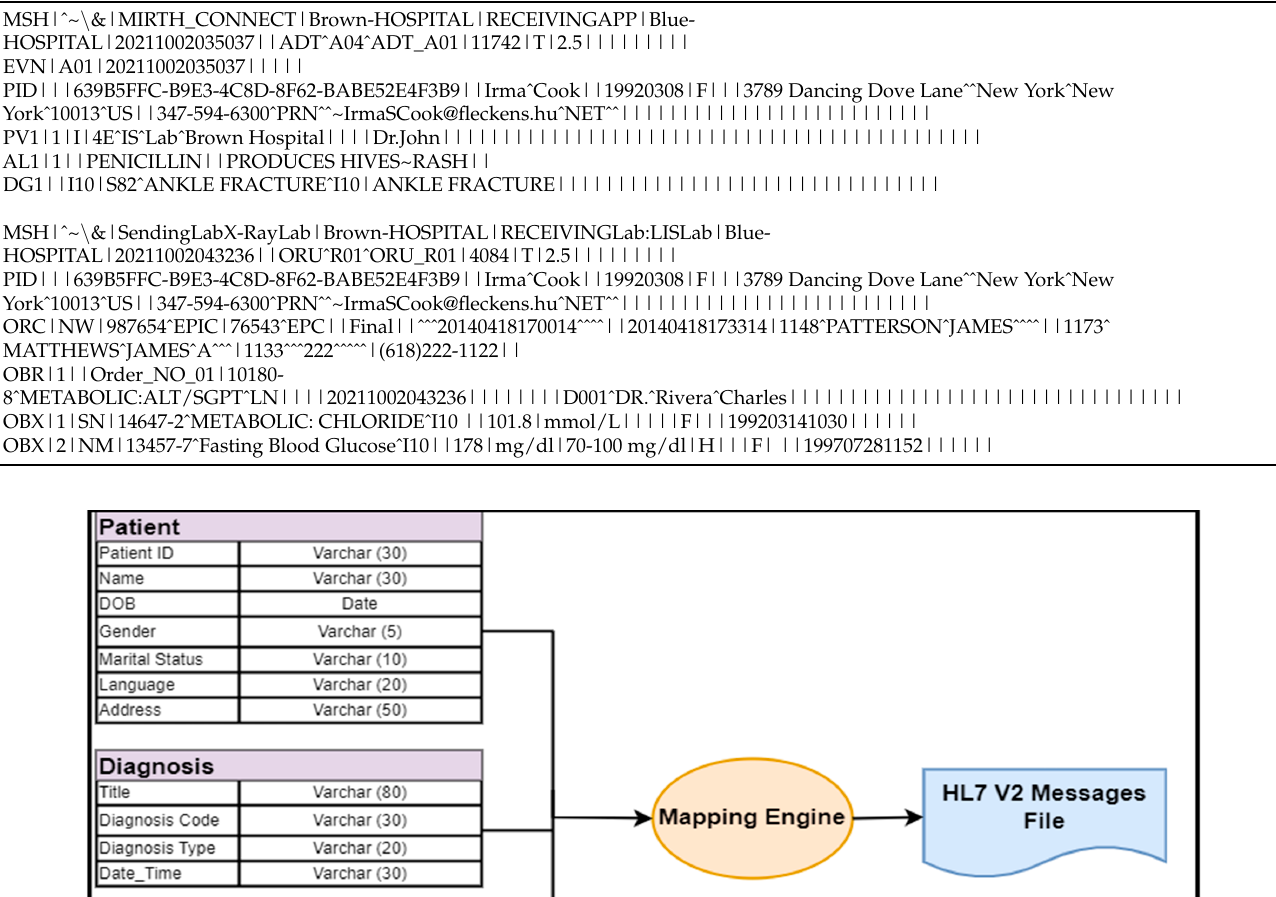
Table 1. Sample messages of the input dataset (HL7 v2).